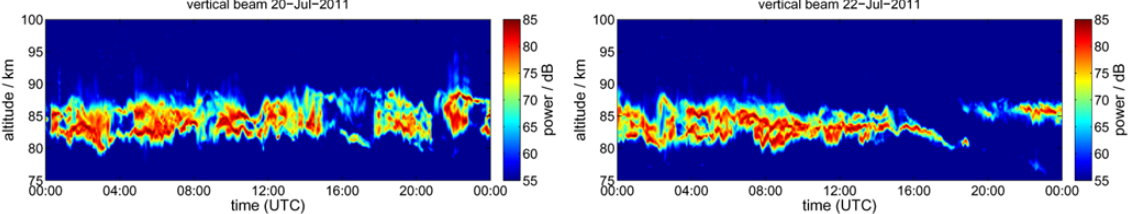
Fig. 3. RTI plots of a PMSE as observed with MAARSY in the vertical beam direction with a vertical resolution of 300m and temporal resolution of 5min. The time is given in